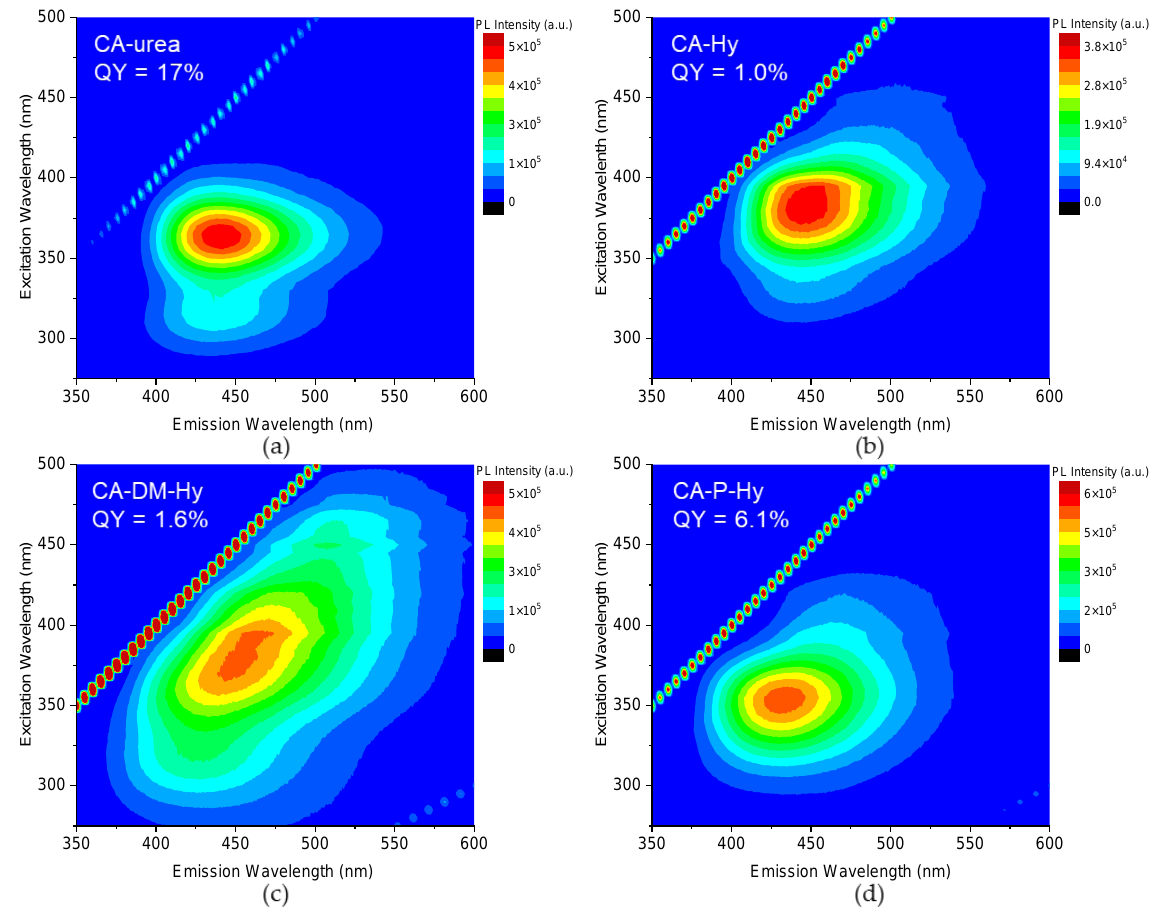
Figure 2. Excitation–emission maps of our reference CA-urea ( a ) compared to CA-Hy ( b ), CA-DM-Hy ( c ) and CA-P-Hy ( d ).